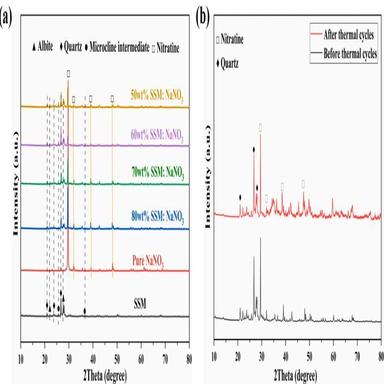
XRD patterns of (a) as-prepared SSM, NaNO3, and ss-CPCMs and (b) A4 before and after 100 thermal cycles.